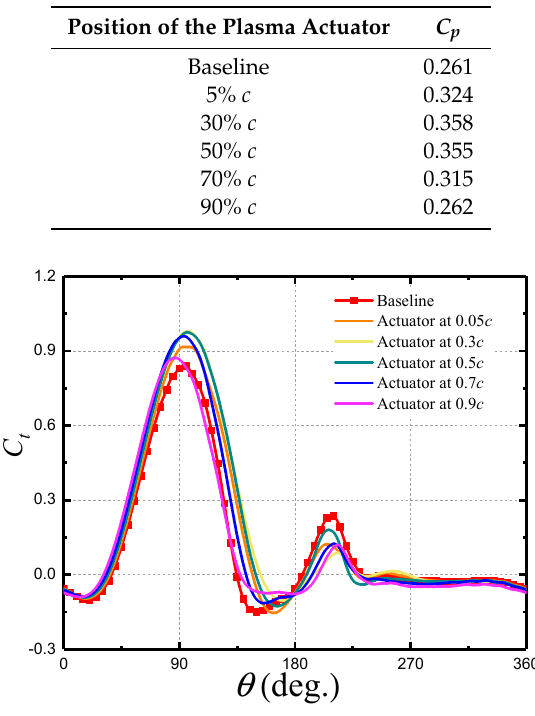
Table 2. C p with different plasma actuator positions.